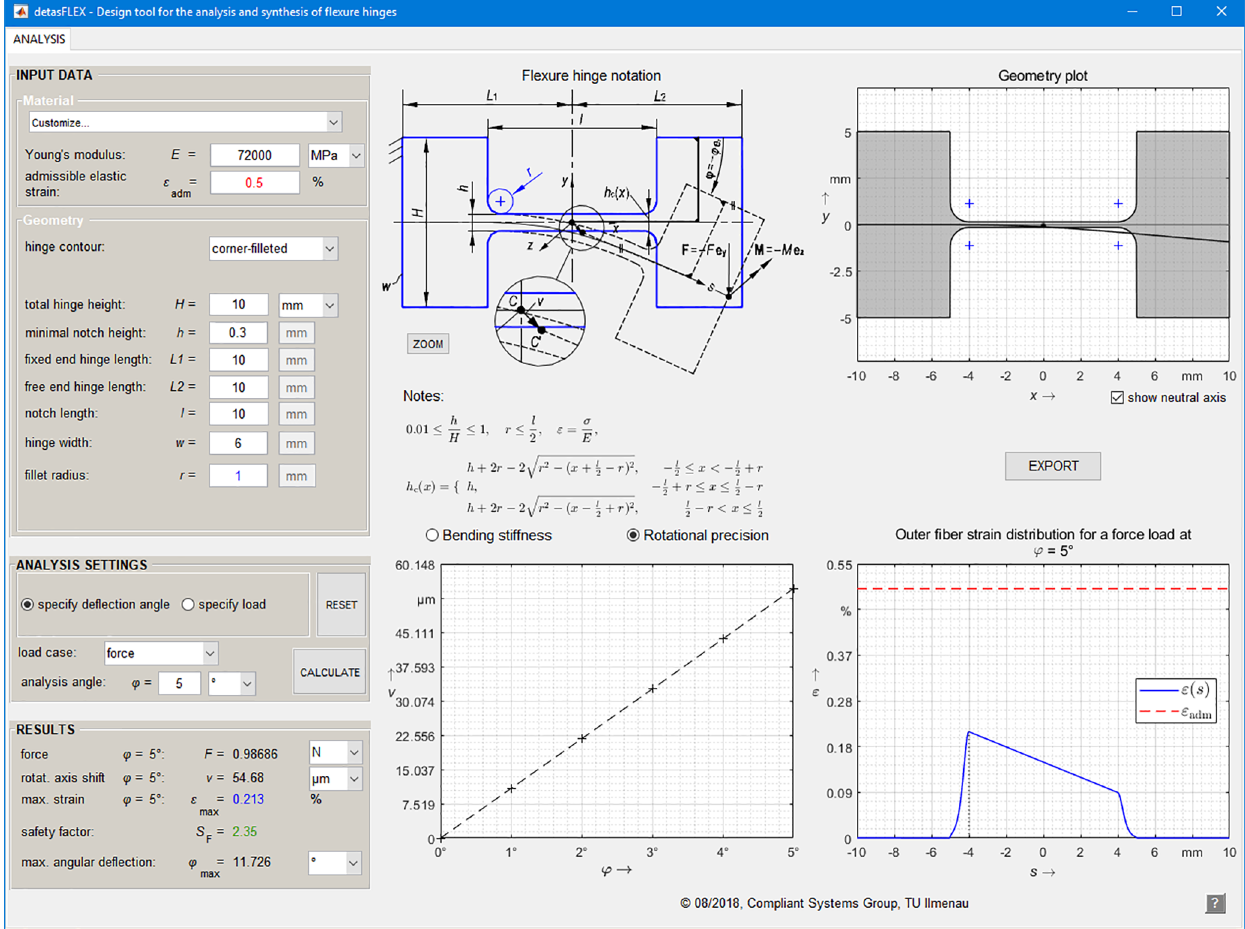
Figure 6. Graphical user interface of the PC program detasFLEX (design tool for the analysis of flexure hinges), shown using the example of a corner-filleted flexure